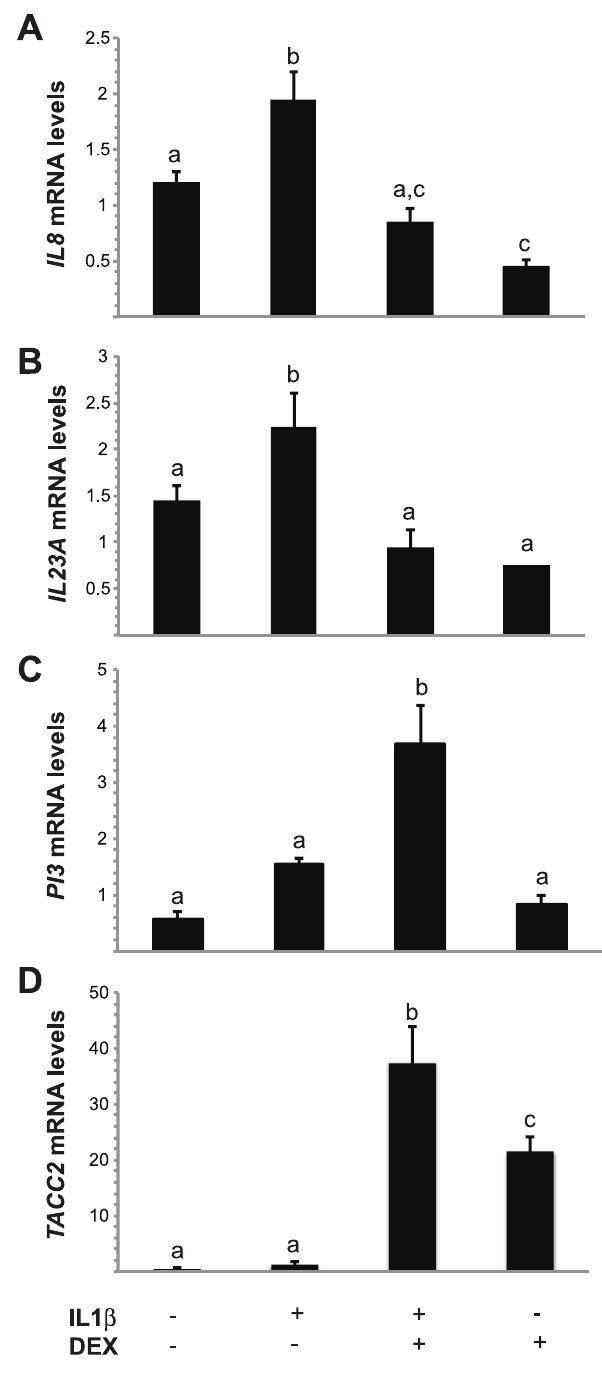
Figure 5. Transcript levels of IL8 , IL23A , PI3 and TACC2 following IL1 b and/or DEX treatment. OE-E6/E7 cells were treated with 10 nM DEX or vehicle 30 h prior to treatment with 50 ng/ml IL1 b or vehicle and harvested 18 h later. Total RNA was extracted and RT-qPCR was performed for IL8 (A), IL23A (B), PI3 (C), TACC2 (D) and were normalized to TBP . Bars represent the mean 6 SEM (n=3 biological replicates performed in triplicate). Bars with different letters are statistically different from one another as determined by ANOVA followed by a Student-Newman-Keuls post-hoc multiple comparison test ( p , 0.05).